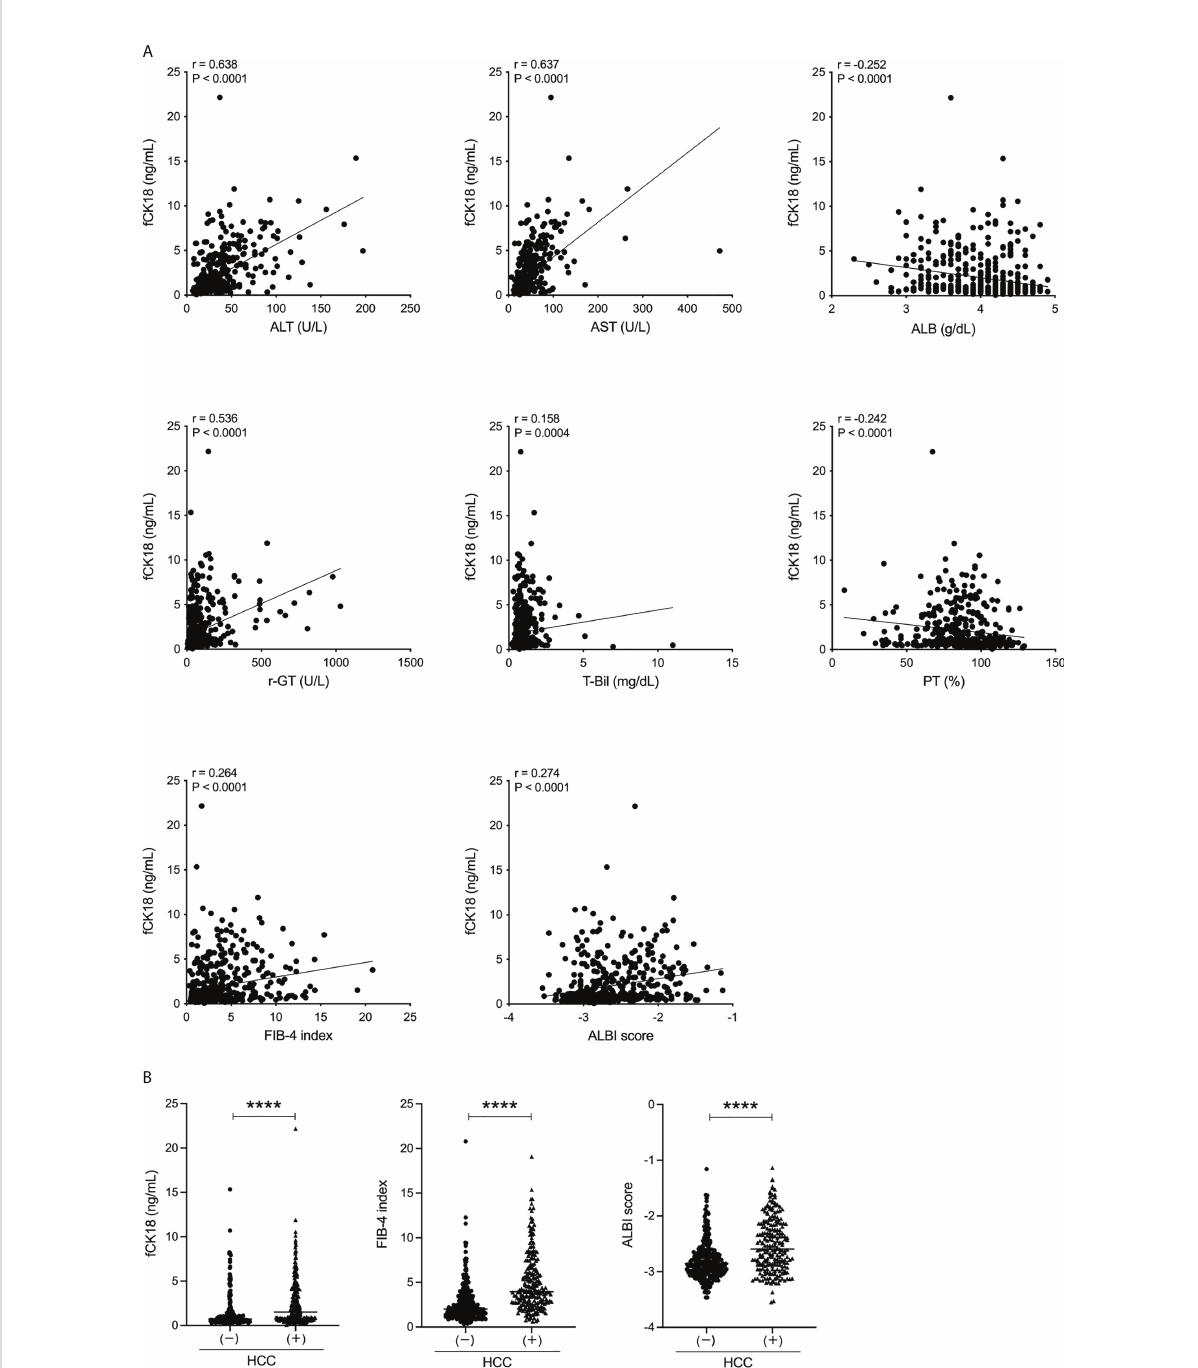
FIGURE 1 Serum fCK18 levels are correlated with liver function in human chronic liver disease and increased in HCC patients. (A) Correlation between serum fCK18 levels and ALT, AST, ALB, g -GT, T-Bil, PT, FIB-4 index and ALBI score. (B) Serum fCK18 levels, FIB-4 index and ALBI score in patients with or without HCC. ****p<0.0001. ALT, alanine aminotransferase; AST, aspartate aminotransferase; ALB, albumin; g -GT, gamma-glutamyltransferase; T-Bil, total bilirubin; PT, prothrombin time; FIB-4, fi brosis-4; ALBI, albumin-bilirubin; fCK18, fragmented cytokeratin